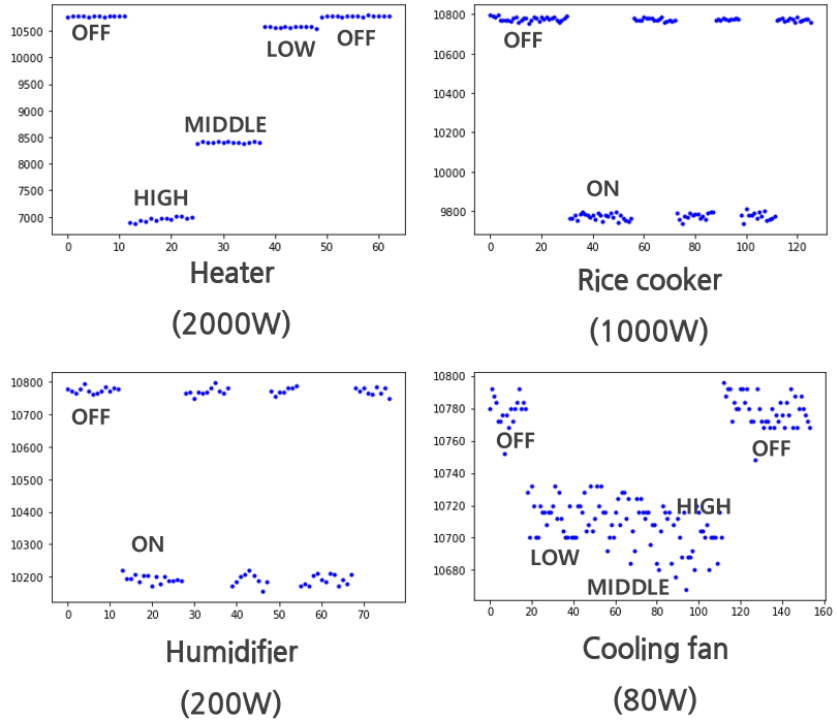
Figure 22. Current amplitude status according to activated appliances.